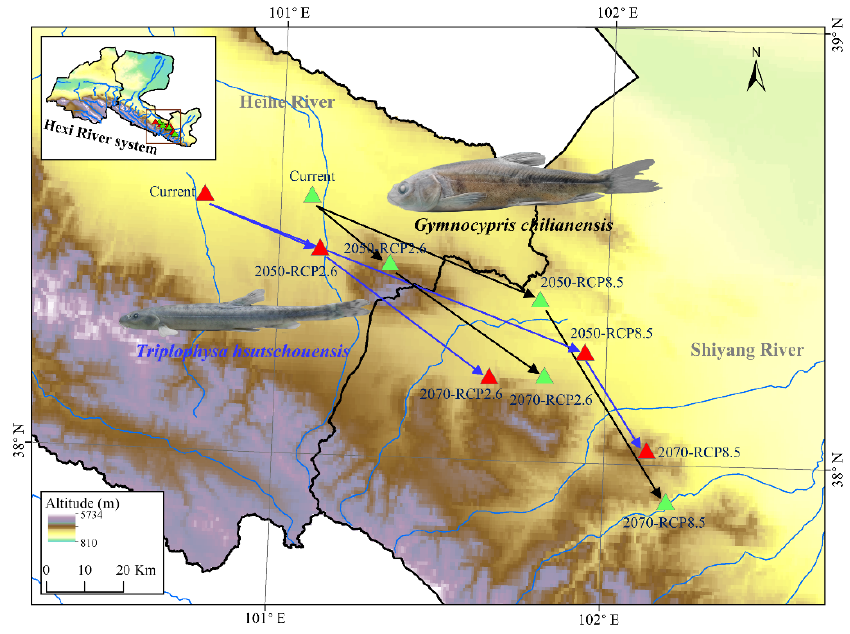
Figure 5. Centroid position of suitable habitat under different climate scenarios for G. chilianensis and T. hsutschouensis